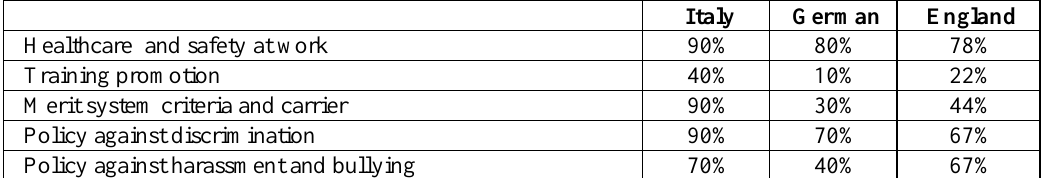
Table 5: Standard Behaviour in Relationship with Management and